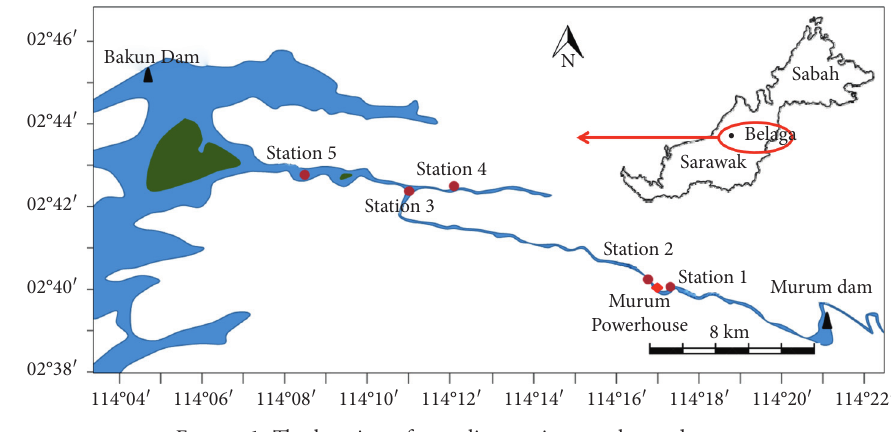
Figure 1: The location of sampling stations at the study